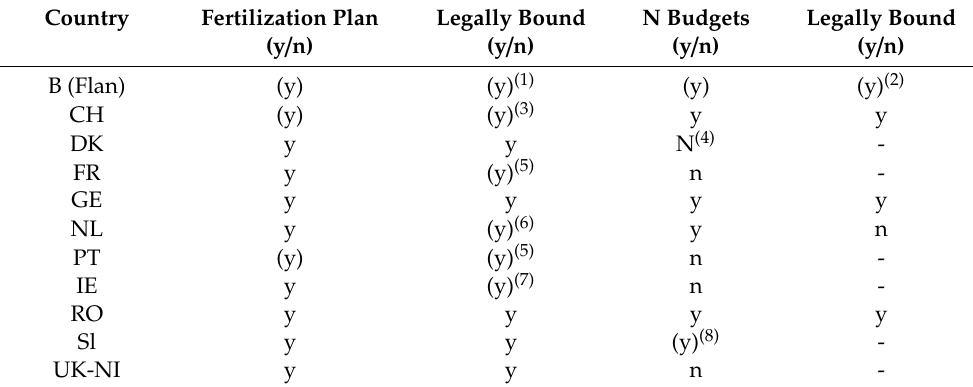
Table 1. Fertilization planning and budgeting at the farm level in EU member states and Switzerland in